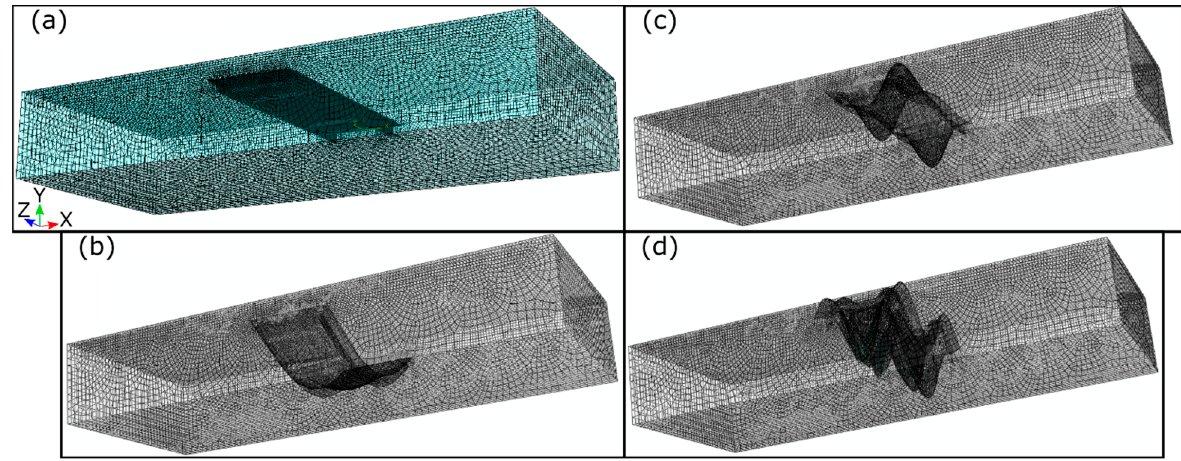
Figure 4. FEM of the small-scale bridge and its dominant modes in the fully inundated condition: ( a ) undeformed FEM; ( b ) 1st mode shape; ( c ) 4th mode shape; ( d ) 17th mode shape.